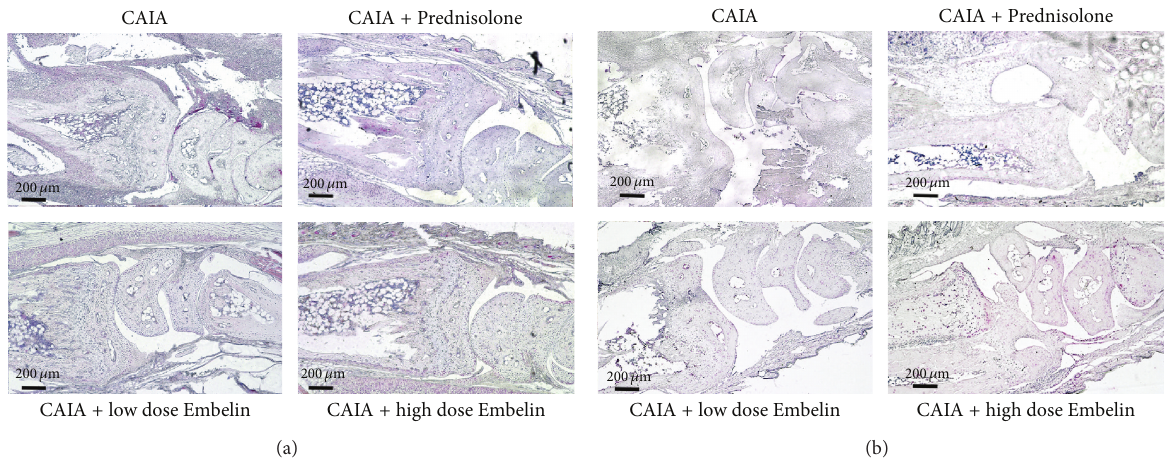
Figure 4: (a) XIAP protein expression (red) in the radiocarpal joint in CAIA mice, in Prednisolone treated mice, in CAIA mice treated with low dose Embelin, and in CAIA mice treated with high dose Embelin. (b) Representative TUNEL staining (indicated in red) in the radiocarpal joint of each mouse group. Hematoxylin counterstaining.